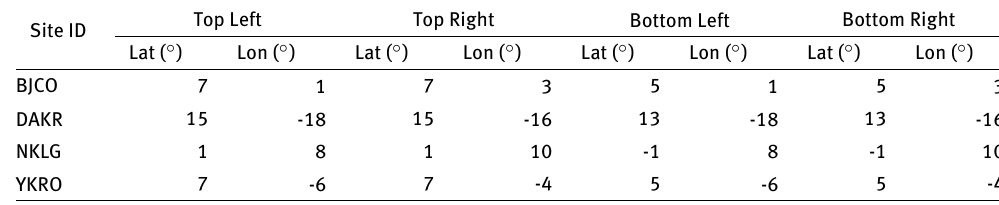
** Lat = Latitude & Lon = Longitude